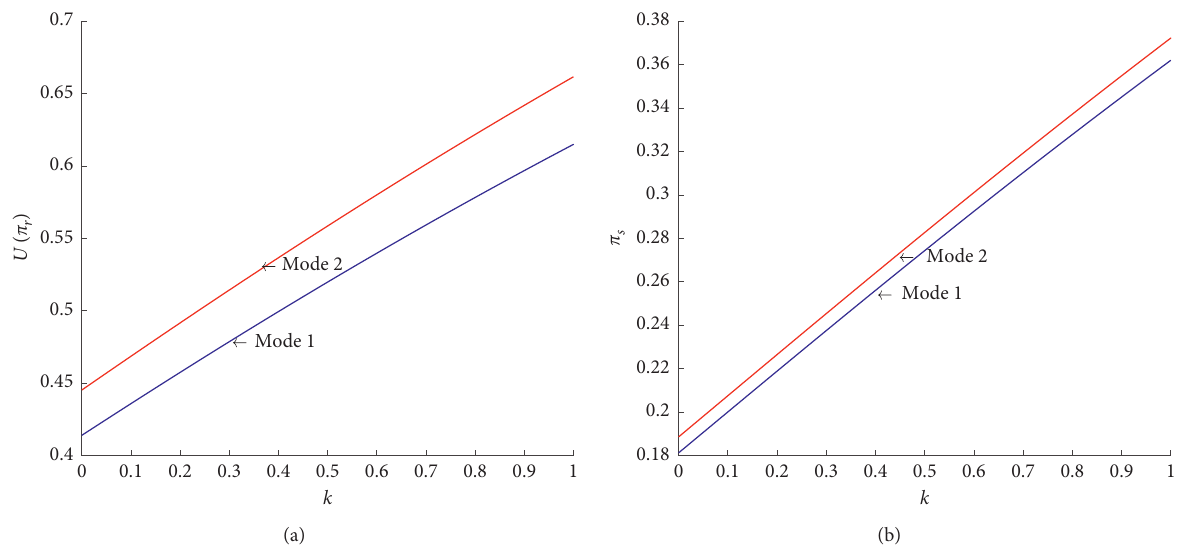
Figure 4: (a) The food processor’s utility as k changes. (b) The supplier’s profit as k